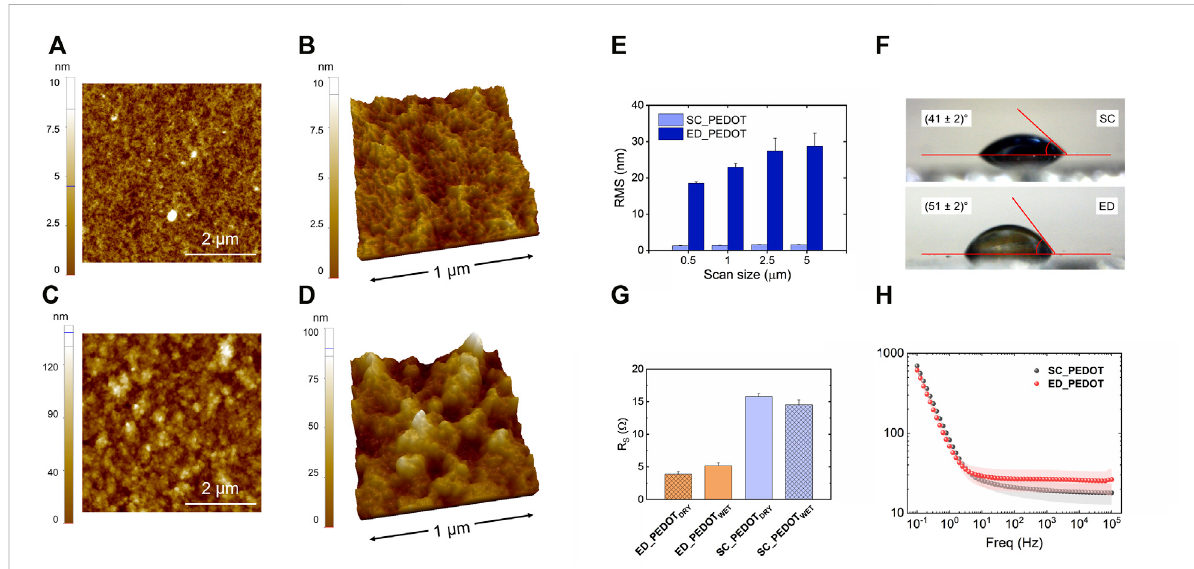
FIGURE 1 SurfacecharacterizationofSC-PEDOTandED-PEDOT fi lms.2D (A,C) and3D (B,D) AFMtopographyimagesofSC-PEDOT (A,B) andED-PEDOT (C,D) fi lms underlying the nanostructuredgranular surface; (E) RMS roughness of both the fi lmsacquired at different length scales; (F) water contact angle values obtained on both the fi lms; (G) dry and wet sheet resistance of SC-PEDOT and ED-PEDOT; (H) Bode |Z| plot of SC-PEDOT and ED-